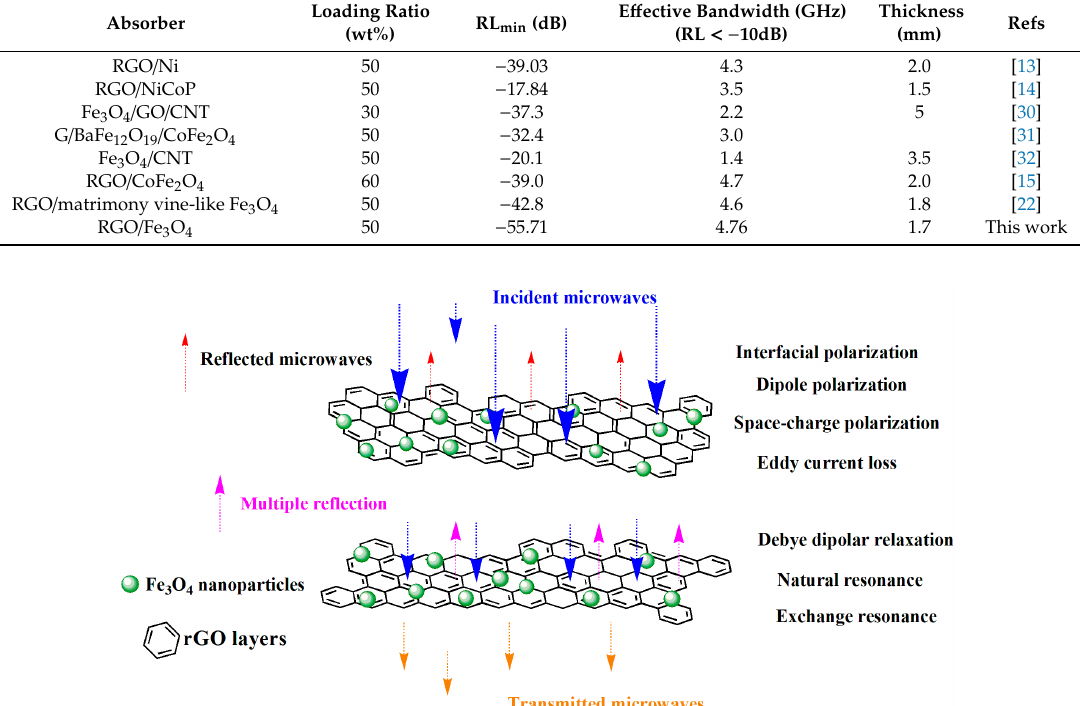
Figure 6. Diagram of microwave absorbing mechanisms for RGO/Fe 3 O 4 nanocomposite.